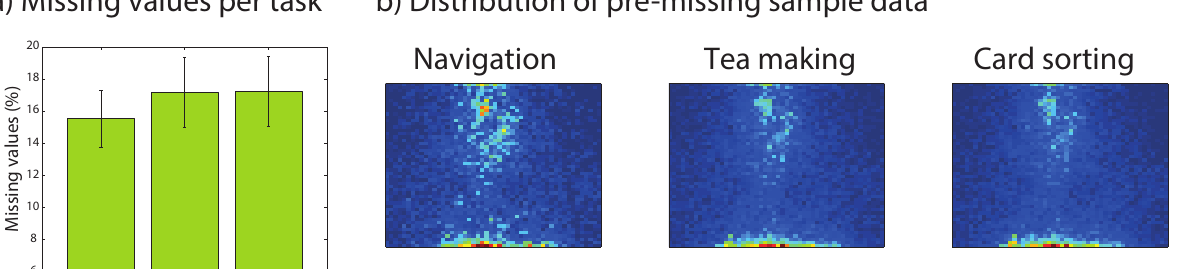
Figure 5 . a) Percentages of missing values per task. b) Distributions of the samples just before missing observations,